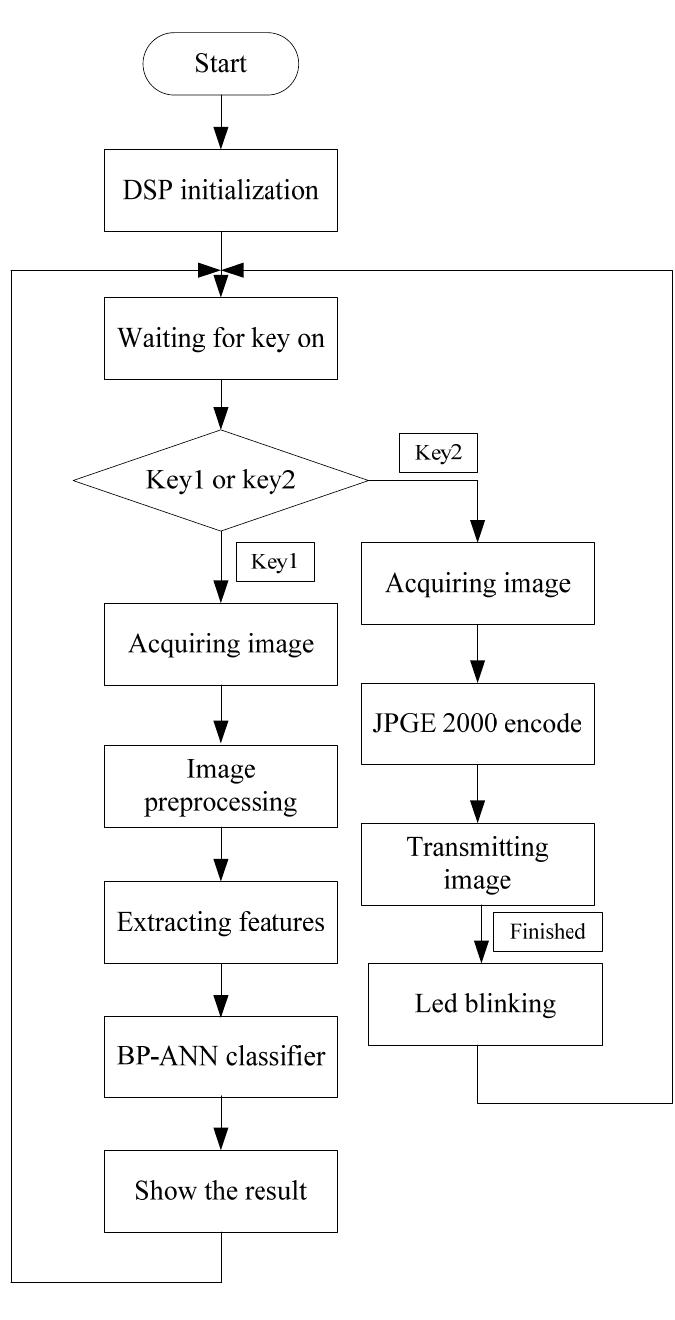
Figure 4. Flow diagram of the DSP program.